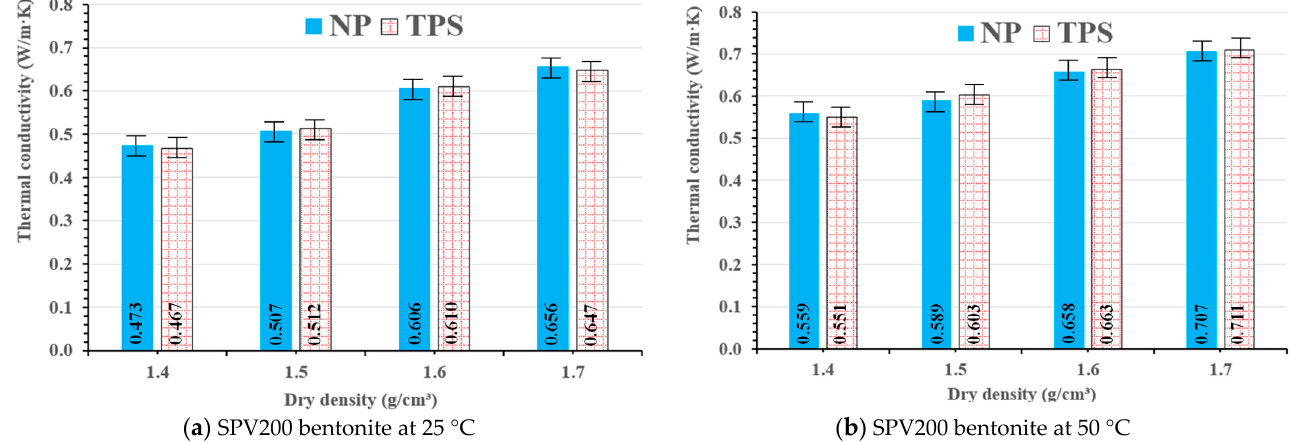
Figure 7. Thermal conductivity of compacted bentonite at varying dry densities.